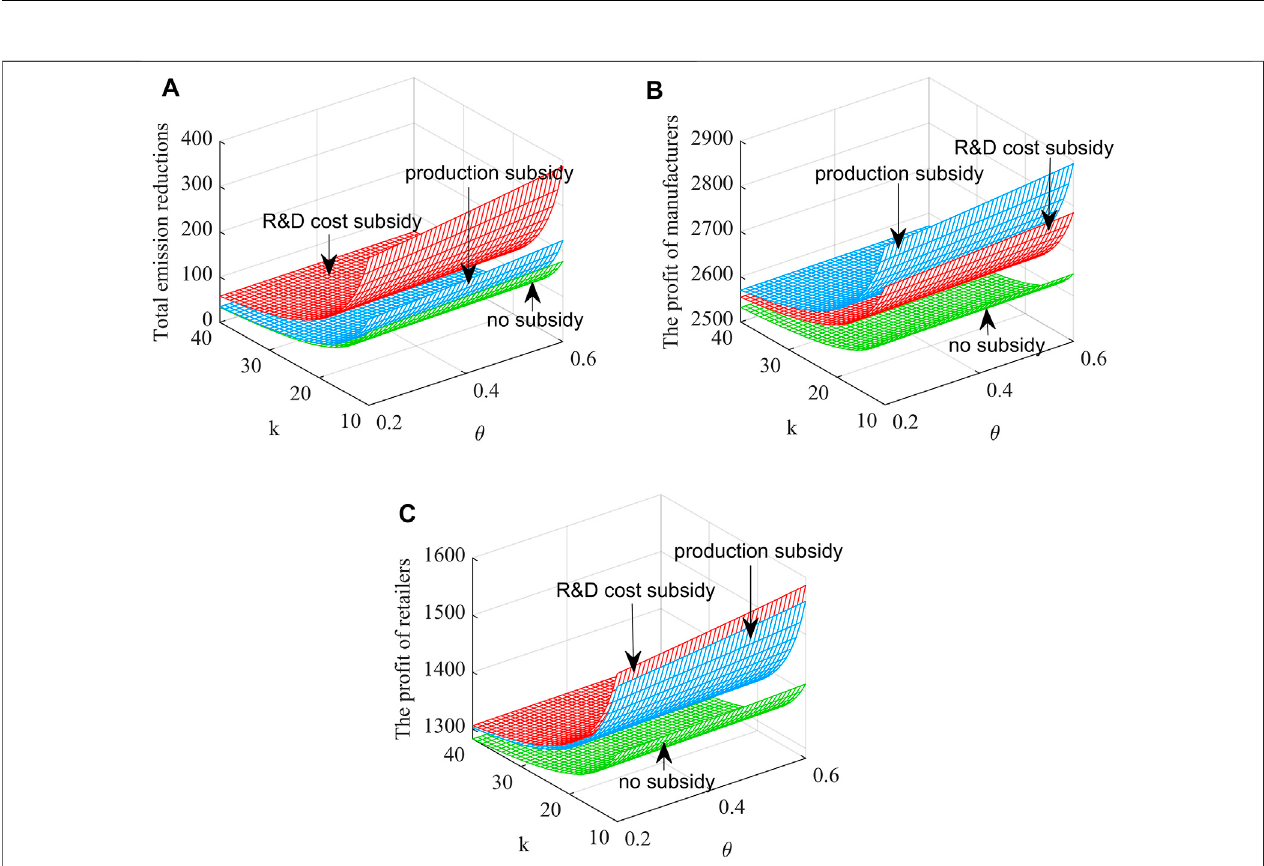
FIGURE 2 | Effect of parameters θ and k on E j , π j m , and π j r . (A) Effect of parameters θ and k on total emission reductions. (B) Effect of parameters θ and k on manufacturers ’ pro fi ts. (C) Effect of parameters θ and k on retailers ’ pro fi ts.